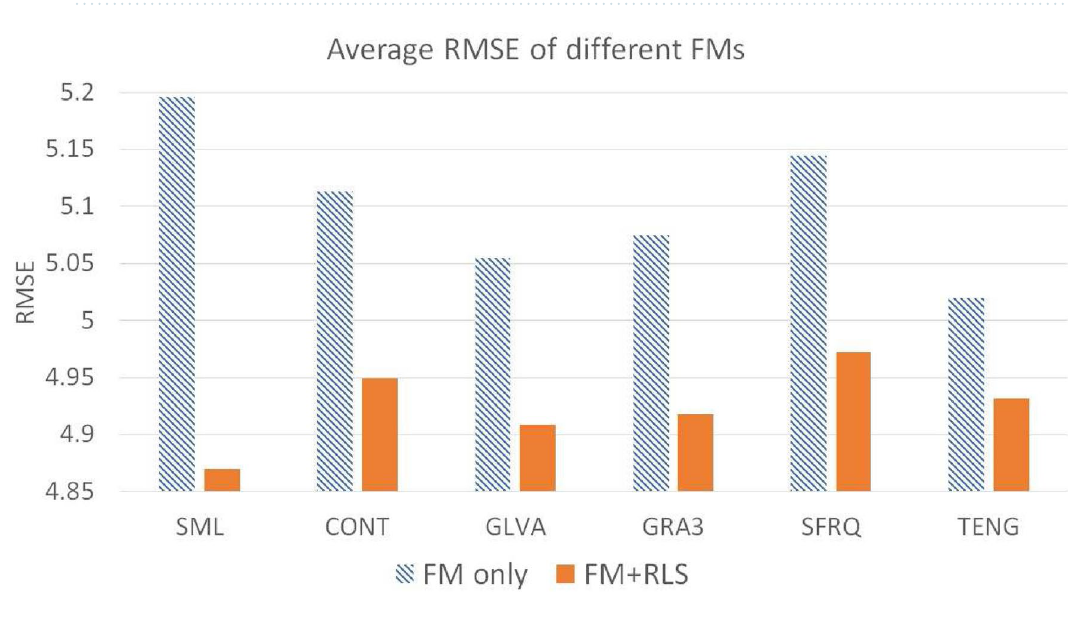
Figure 6. Average of Correlation for different FMs for Jitter noise σ 2 ξ 0 2 . σ 2 ζ ≤ ≤